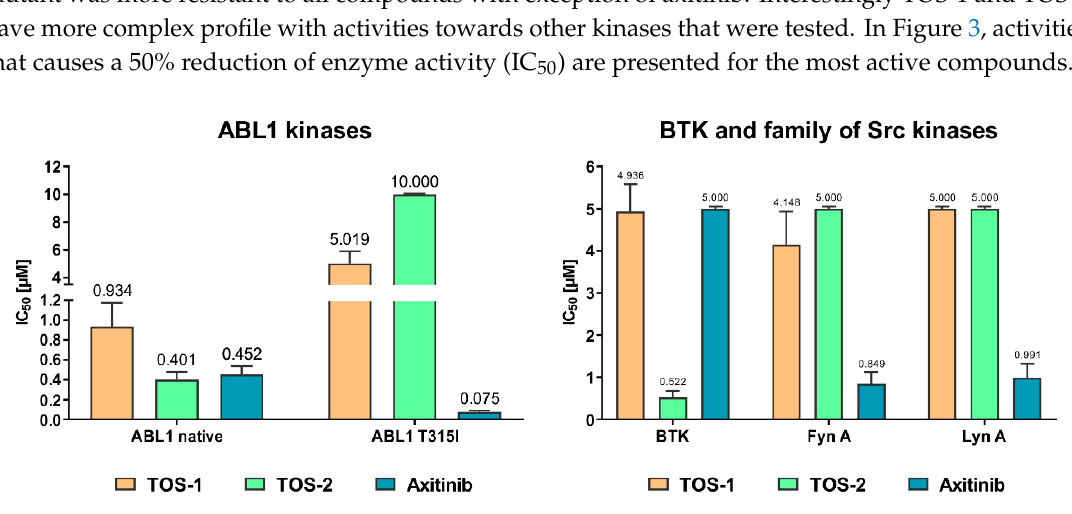
Figure 3. The IC 50 values of the tested inhibitors against the non-receptor tyrosine kinases.